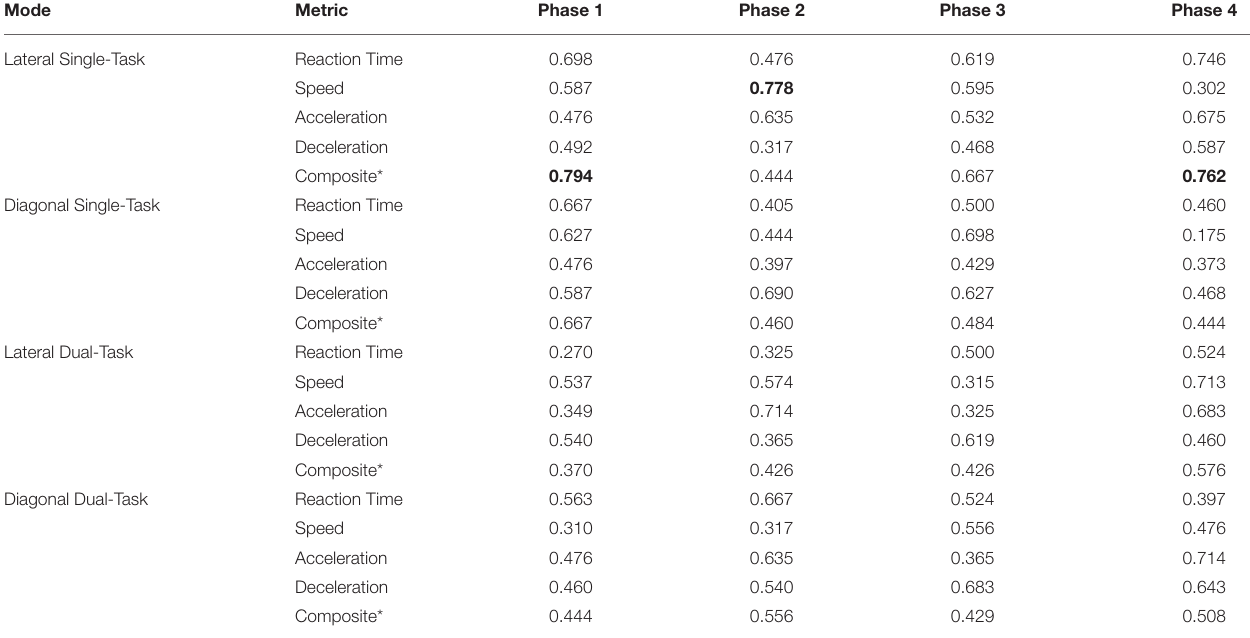
TABLE 6 | Receiver operating characteristic area under curve values for Asymmetry of Left and Right performance metrics for each task mode.